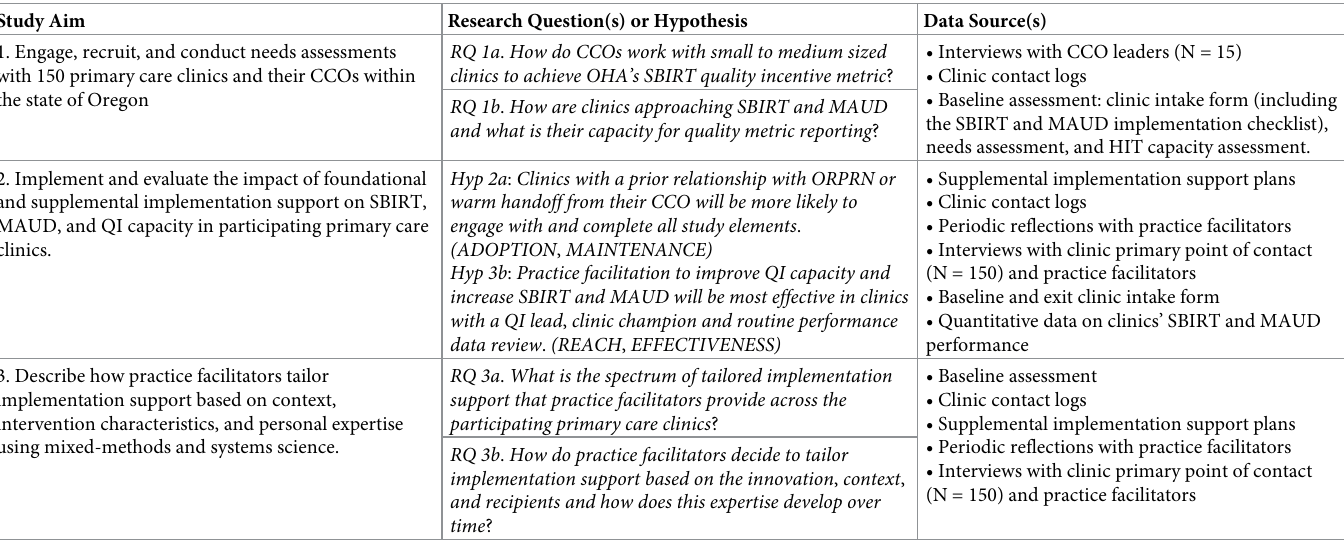
Table 1. Specific aims, research questions, hypotheses, and data sources (N ~ 150 unless specified). Study